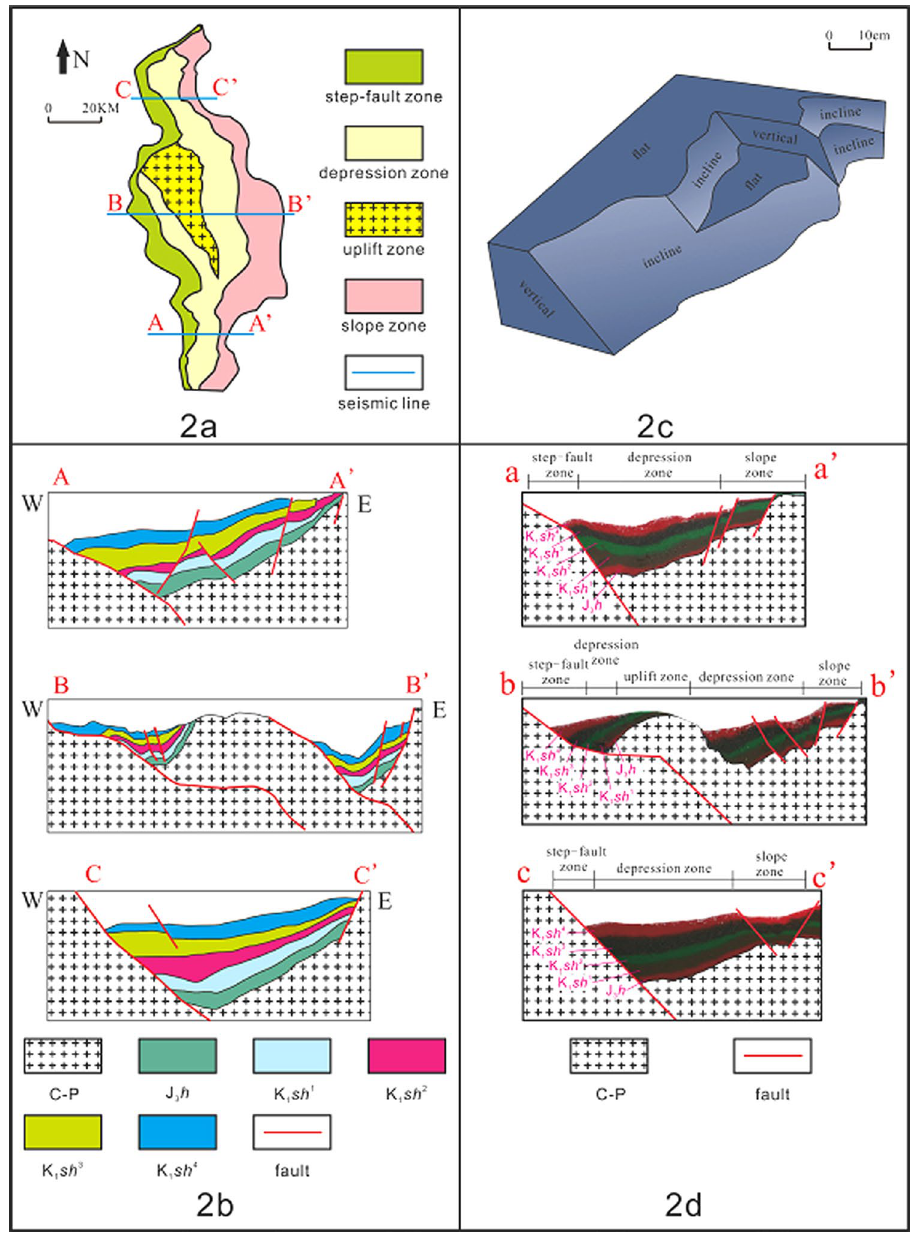
Figure 2. ( a ) The tectonic map of the XJWZ depression showing the controlling normal fault to the west (adapted from Figs 2–14 presented by Ren 19 ). ( b ) The seismic observation showing the development of a symmetric anticline in the middle of the XJWZ depression. ( c ) The shape of basement used in the 3-D simulation box. ( d ) The result of the 3-D simulation. The figures were produced using the CorelDRAW software (Version X8)